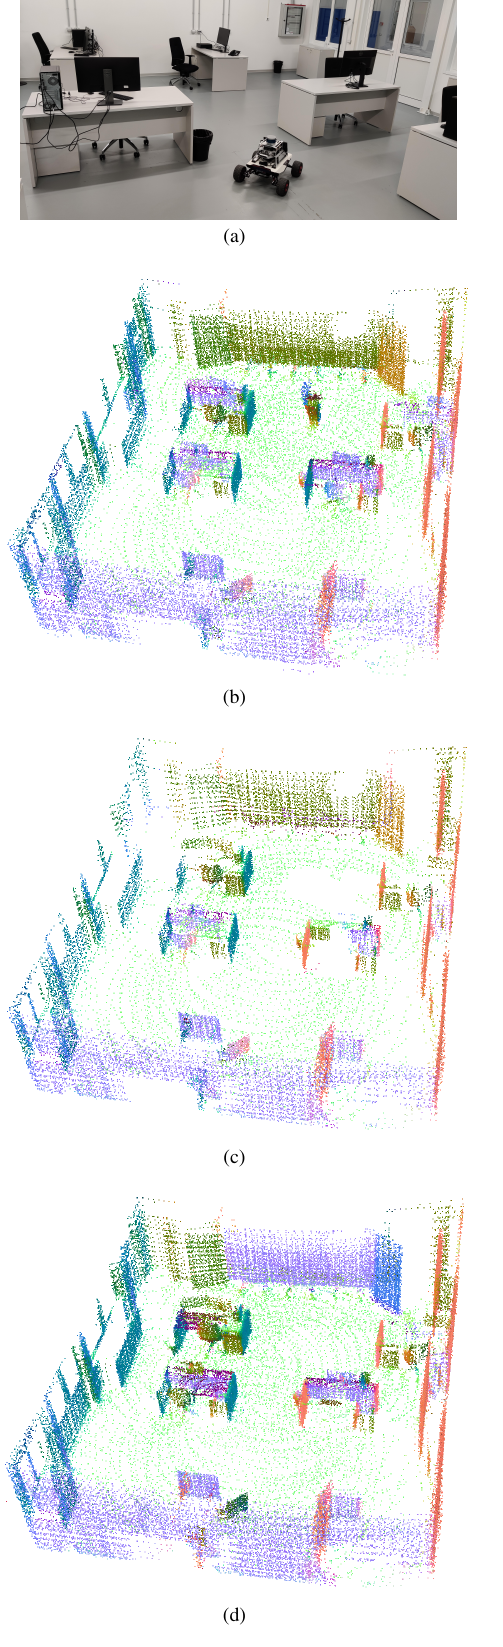
Figure 8. Test case (2): scanned environment (a); people detected (b); point cloud with data gaps (c); final point cloud